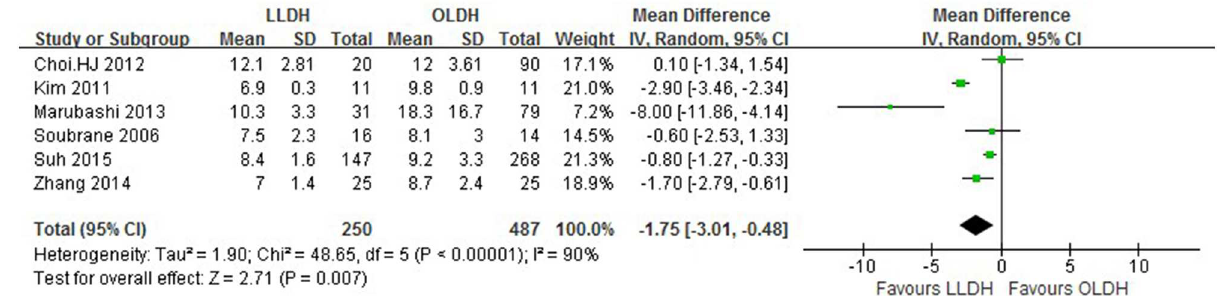
Fig 5. Forest plot displaying the results of the meta-analysis on hospital